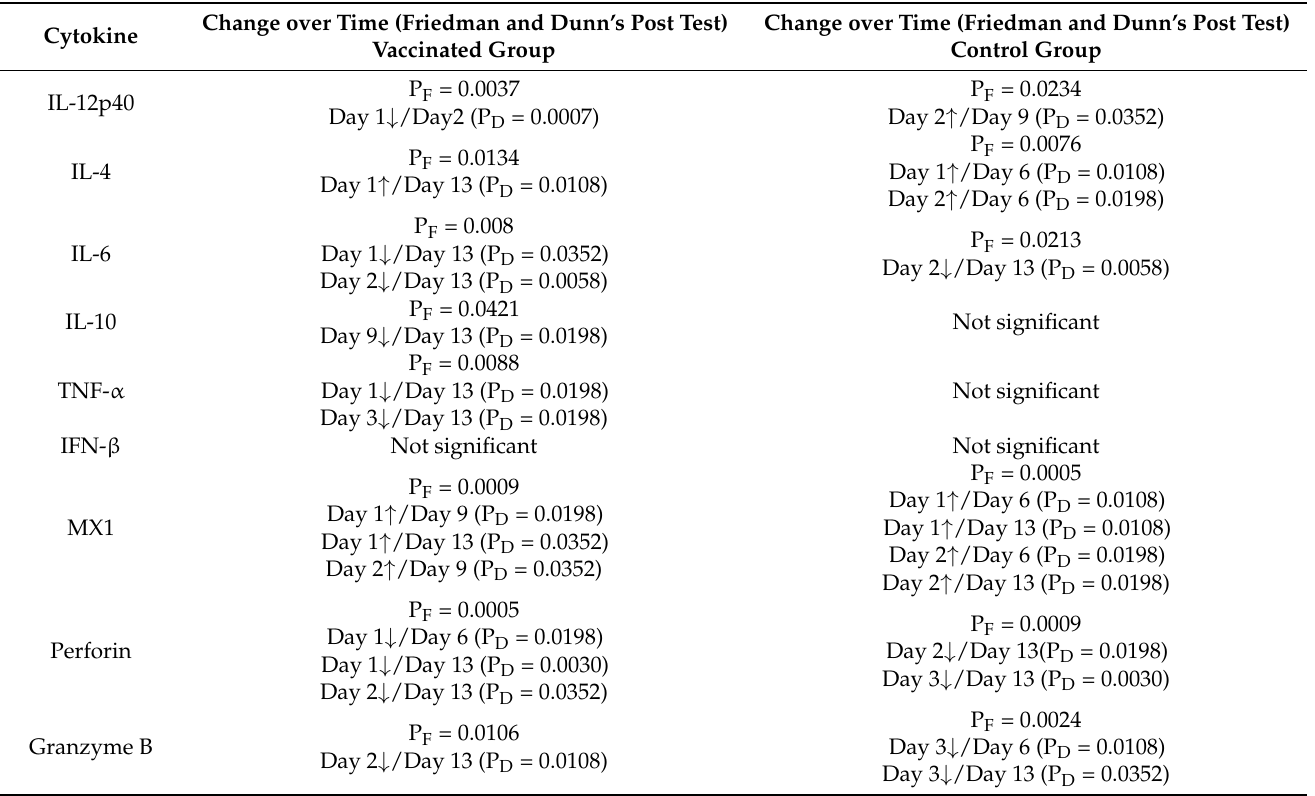
Table A8. Results of the Friedman and Dunn’s post test of lymphocyte subsets after FCV Challenge II. Lymphocyte